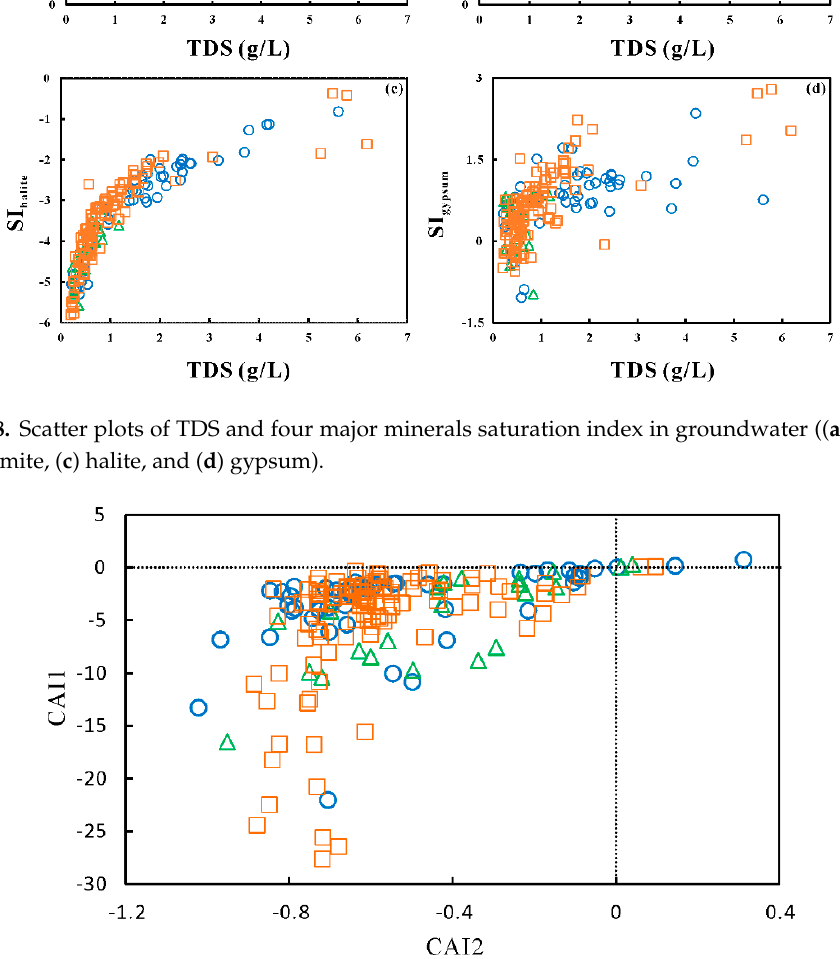
Figure 10. Scatter plot of δ 18 O against Cl − contents for the groundwater samples in the study area. 5.3. Anthropogenic Factors Affecting Groundwater Chemistry Considering that Yuncheng city is one of the major crop yield areas in Shanxi Province, Northern China, agriculture activity is the dominant anthropogenic factor response for groundwater quality